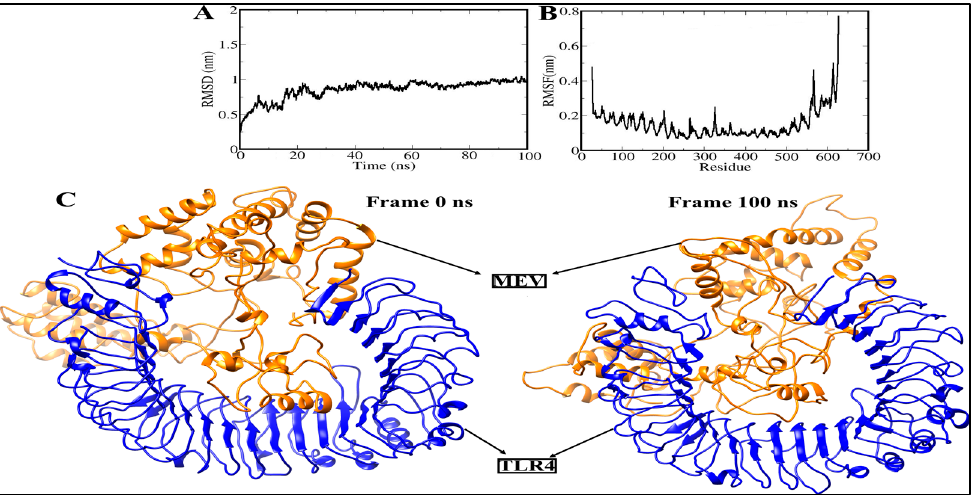
Figure 6. Structural stability analysis of simulated vaccine–receptor complexes: ( A ) RMSD and ( B ) RMSF. ( C ) The 3D view of multiepitope vaccine-TLR4 of frame 0 ns and frame 100 ns.